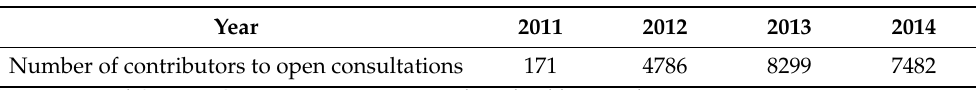
Table 1. Increase in the number of contributors to public consultations conducted via individual websites of government bodies from 2011 to 2014. Year 2011 2012 2013 2014 Number of contributors to open consultations